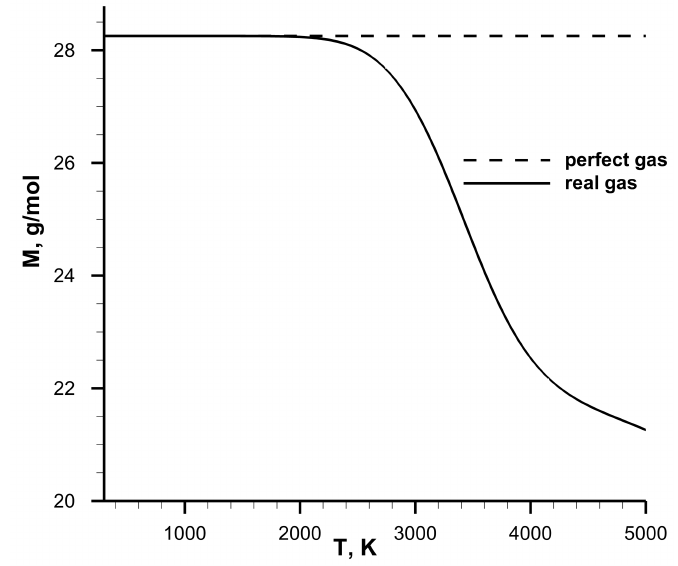
Figure 3. Molar mass of the methane-air